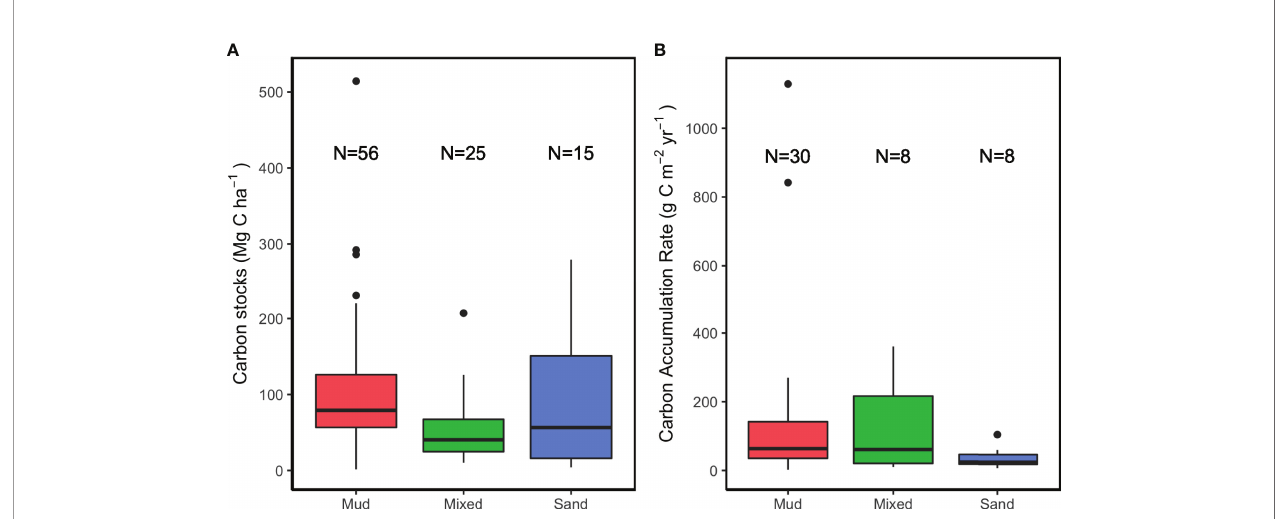
FIGURE 3 | Comparison of sediment C sequestration in tidal fl ats of different sediment types. Comparison of sediment C stock and CAR in mud fl ats and sand fl ats are shown in (A, B) , respectively. Studies without information on grain sizes are not included in the